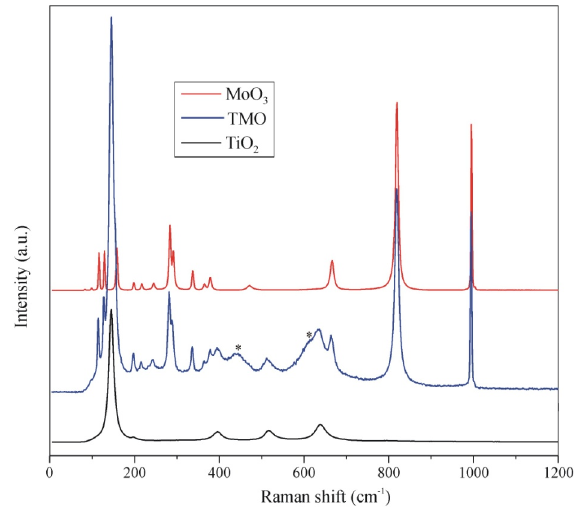
Figure 2. Raman spectra of the starting powders of anatase TiO 2 (black line) and MoO 3 (red line) and prepared TMO (blue line). The asterisk (*) shows the E g and A 1g vibration modes of the rutile TiO 2 structure.